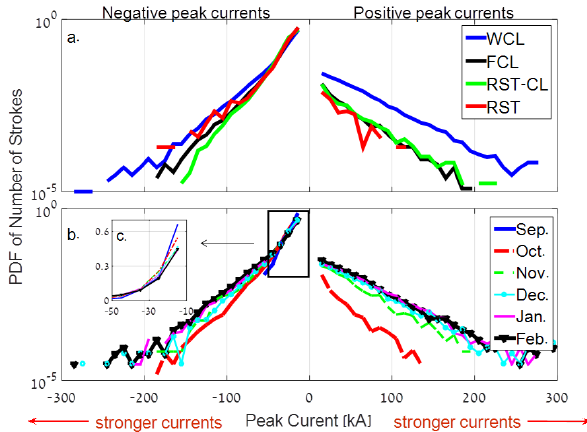
Figure 9. (a) PDF of peak currents (kA) in logarithmic scale as a function of synoptic system. The integral under each curve of posi- tive and negative strokes per synoptic system equals 1; (b) monthly PDF for FCL and WCL systems, in logarithmic scale; (c) zoom-in window for the area between − 35 and − 10kA, marked with a black box on panel (b) ; it highlights the temporal decrease in fraction of negative weak